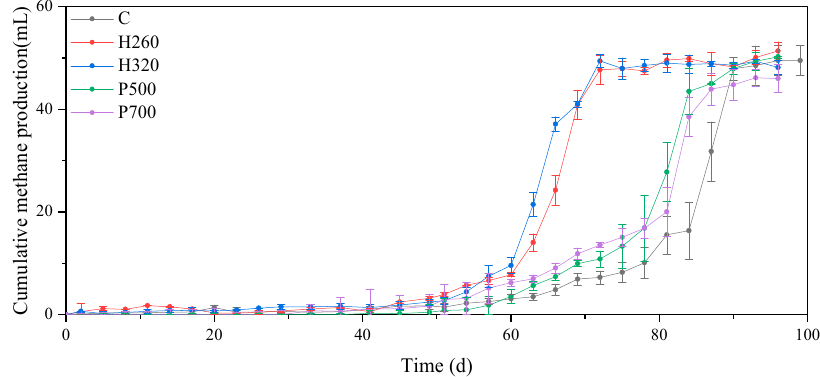
Figure 1. Changes of cumulative methane production after adding H260, H320, P500, and P700.